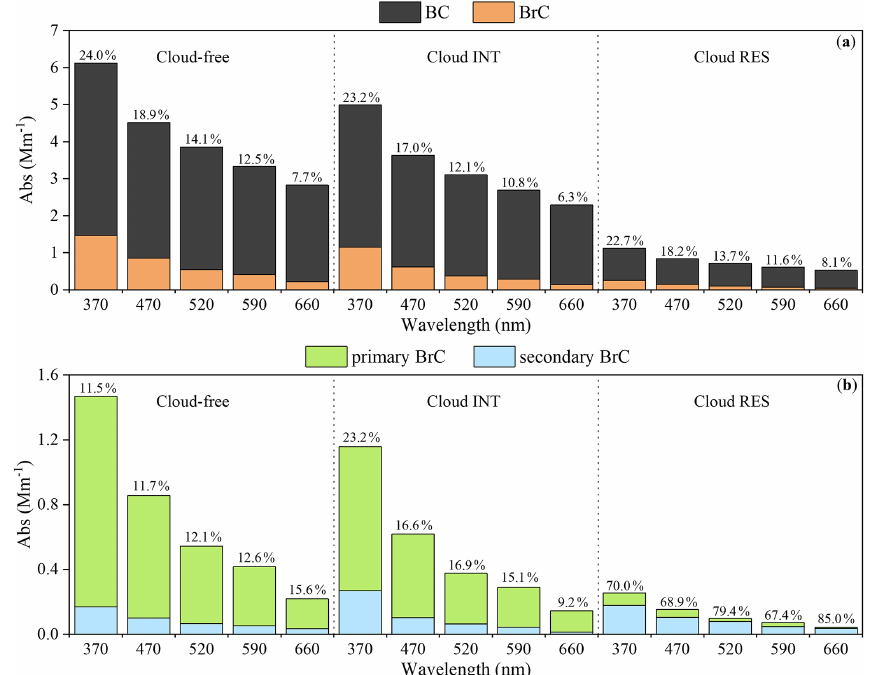
Figure 2. The light absorption of (a) BrC and BC; (b) primary BrC and secondary BrC at different wavelengths; the percentages represent the contribution of (a) BrC light absorption to the total particle light absorption; (b) secondary BrC light absorption to the total BrC light absorption in the cloud-free, cloud INT, and cloud RES particles,